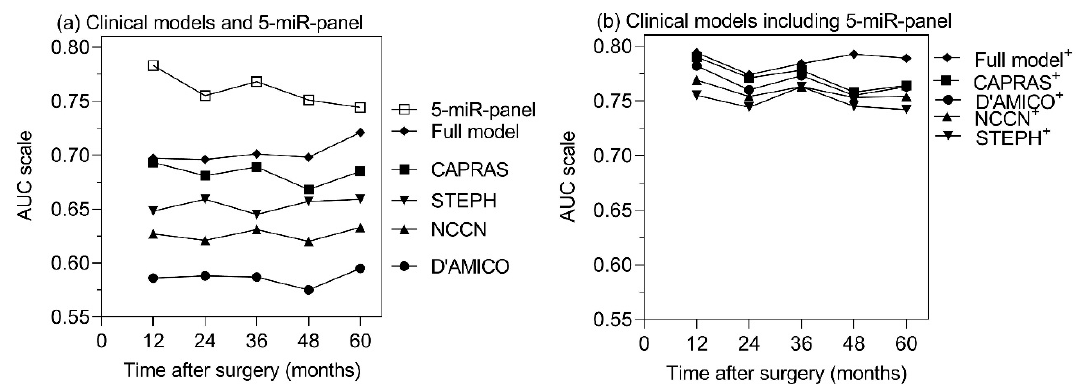
Figure 3. Time-dependent receiver-operating characteristics (ROC) curve analyses of ( a ) separate and ( b ) combined miRNA panel-based and clinicopathological factors-based models at di ff erent postoperative time points. Areas under the time-dependent ROC curve (AUCs) of all models were computed